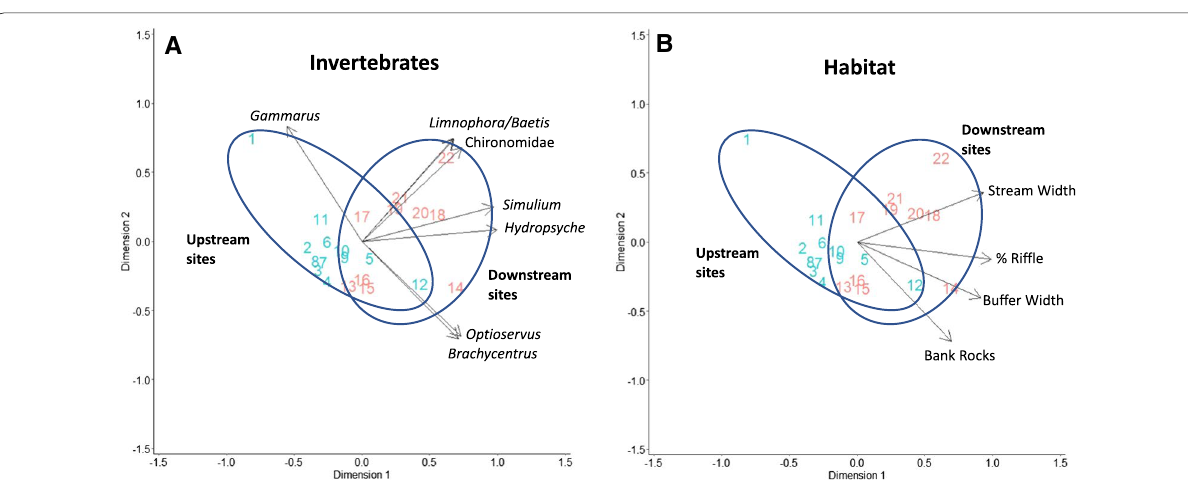
Fig. 3 Non-metric multidimensional scaling ordination (NMDS) biplots of 22 stream sites on the South Fork Whitewater River, Minnesota, USA, based on abundances of benthic invertebrates and stream habitat variables at each site. Numbers represent sites (see Fig. 1), separate ellipses enclose the 12 upstream sites and the 10 downstream sites, and arrows represent locations of greatest abundance for invertebrates ( A ) and strongest influence of stream habitat variables ( B ) whose values were statistically ( α 0.05) correlated with the complete NMDS model (see Table =